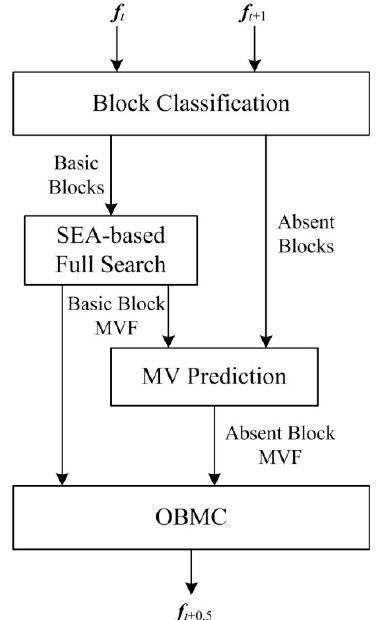
Figure 1. A flowchart of the proposed SP-MCFI algorithm.